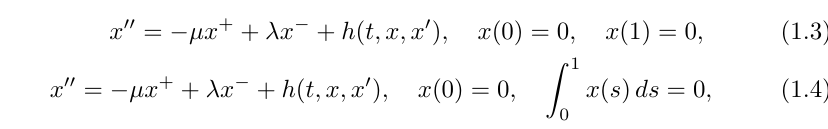
Figure 2. The spectrum of the problem